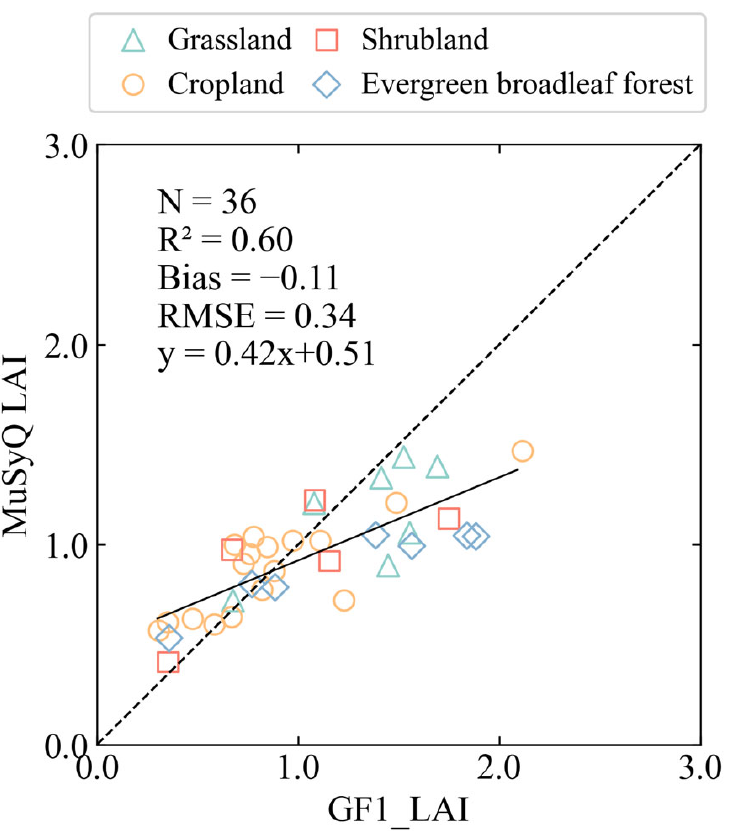
Figure 8. Comparison of MuSyQ LAI and GF1_LAI. The black dashed line indicates a 1:1 relationship and the solid line shows the linear regression between GF1_LAI and MuSyQ LAI.